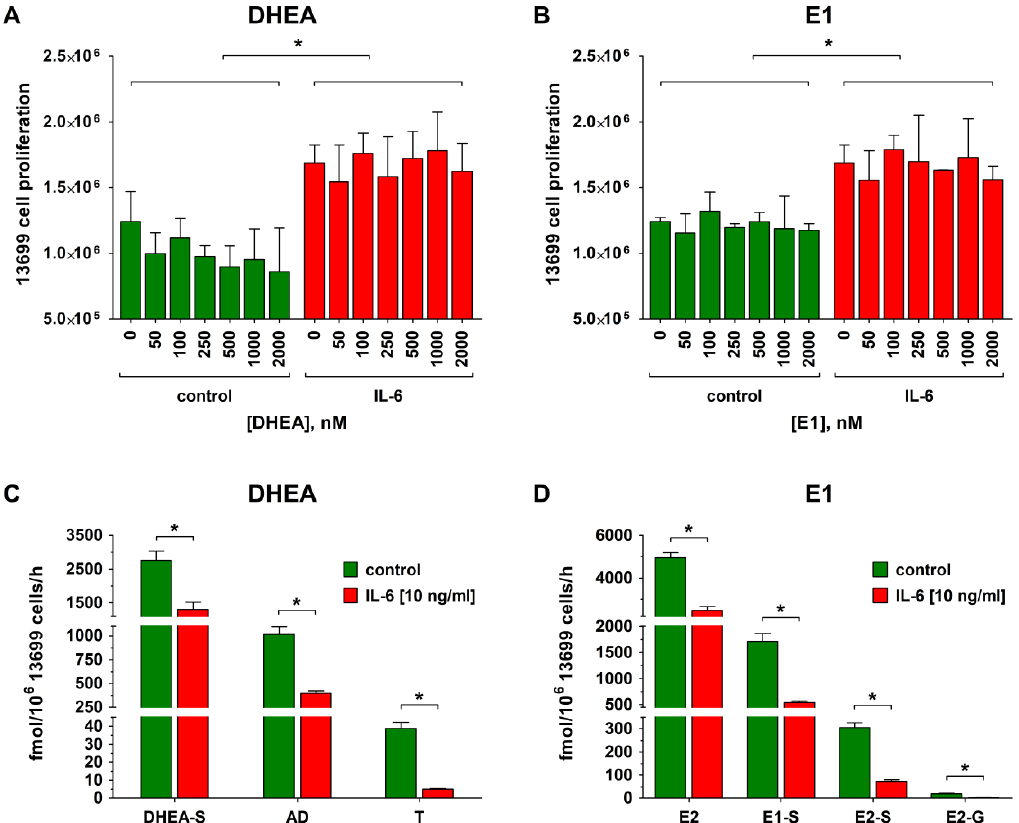
Figure 4. Effect of IL-6 treatment on proliferation and steroid metabolism of 13699 cells. Platinum-sensitive 13699 cells, demonstrating a low endogenous IL-6 formation (2.75 pg / 10 6 cells / h), were incubated with IL-6 (10 ng / mL) for 72 h, followed by incubation with IL-6 in the presence of increasing concentrations (0 to 2000 nM) of ( A ) DHEA and ( B ) E1 for 48 h and the viable cells were counted on a CASY ® TT cell counter. Subsequently, the cellular supernatants of the samples containing 2000 nM of the steroid precursor ( C ) DHEA or ( D ) E1 were analyzed for steroid metabolites using liquid chromatography high-resolution mass spectrometry (LC-HRMS). Green indicates sensitivity for carboplatin and red represents carboplatin resistance. All data are presented as the means ± SD of three independent experiments. * p < 0.05.